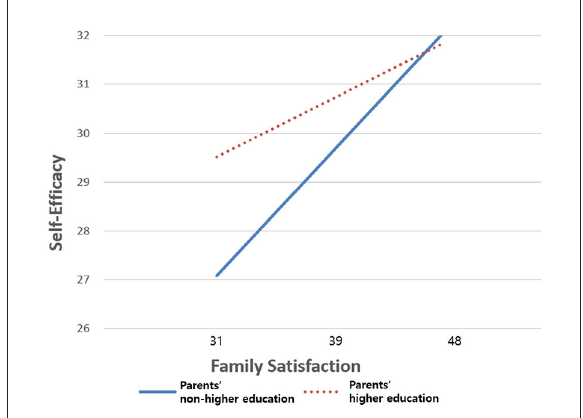
FIGURE2 Moderating effect of parents’ educational attainment on the relationship between family satisfaction and self-efficacy among low-income